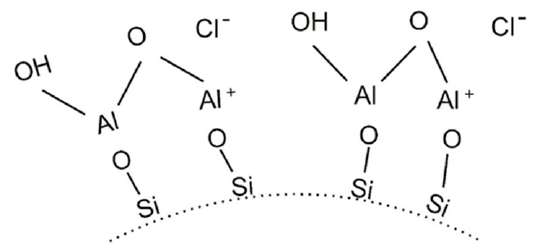
Figure 7. Surface modification of a SiO 2 particle to change the particle charge to positive, adapted from [53].